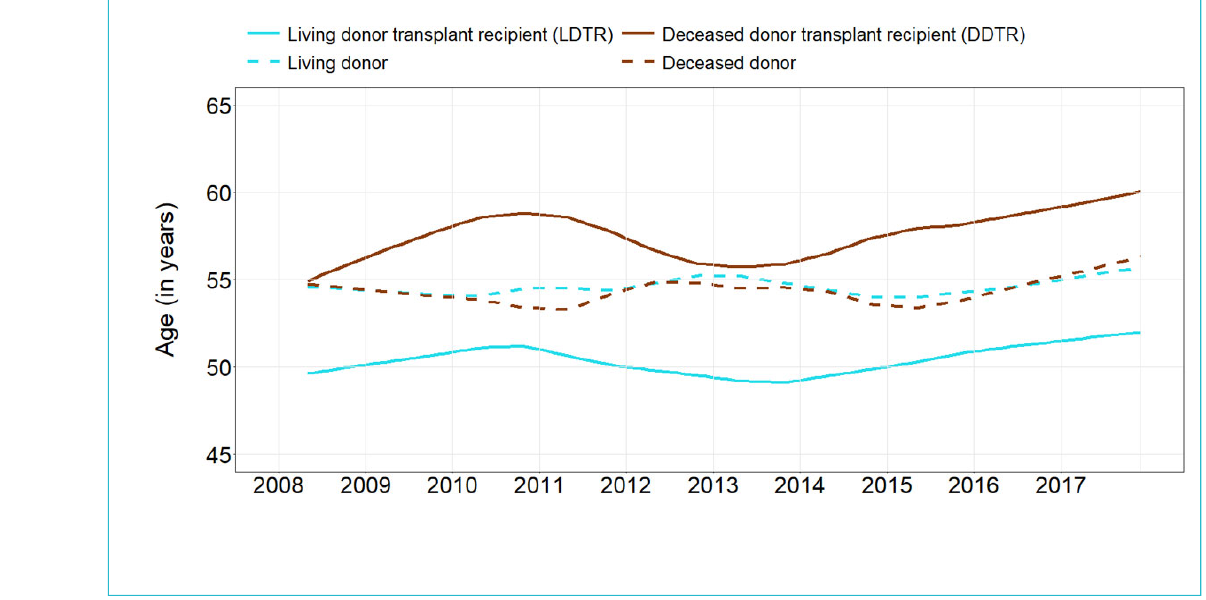
Figure 5: Time to discontinuation of prednisone in renal transplant survivors without graft failure * , stratified by immunosuppression thera- py.“TAC-based” was defined as the combination of prednisone, tacrolimus and mycophenolate mofetil. “CsA-based” corresponds to the combi- nation of ciclosporin, prednisone and mycophenolate mofetil.* There is no test statistic provided for the difference of the two curves to prevent any causal conclusions drawn about the effect of different IS treatments on time to prednisone discontinuation (for further explanation see fig. S4 in appendix